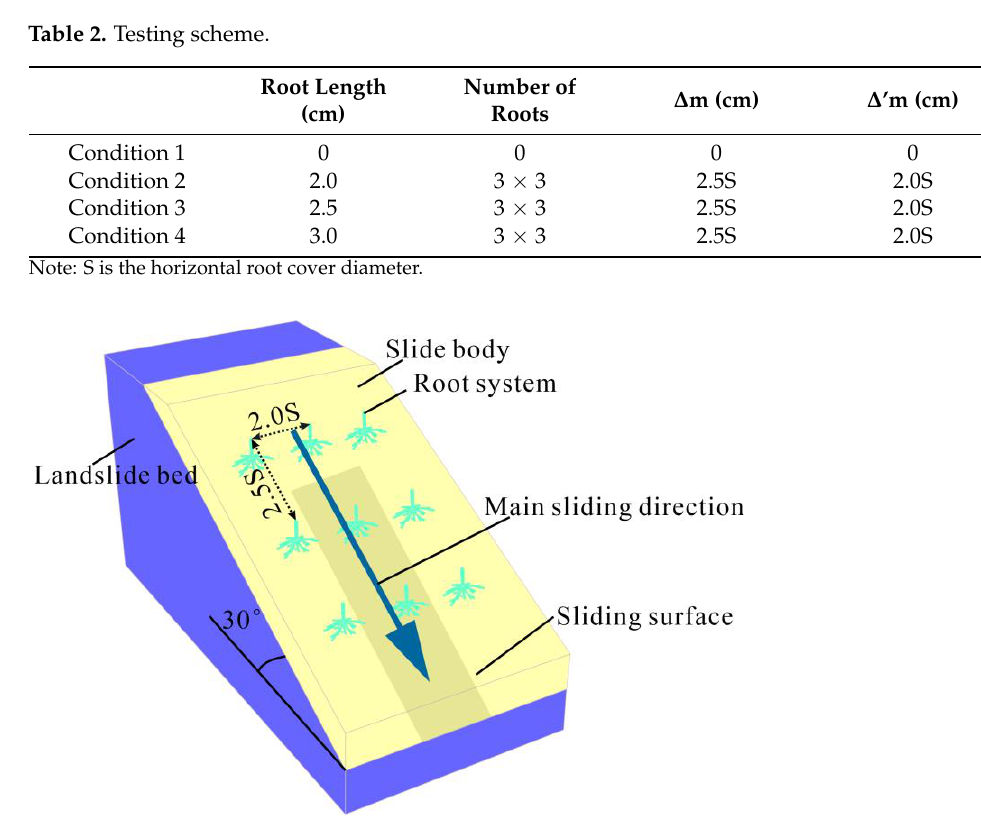
Figure 6. Schematic diagram of root arrangement.